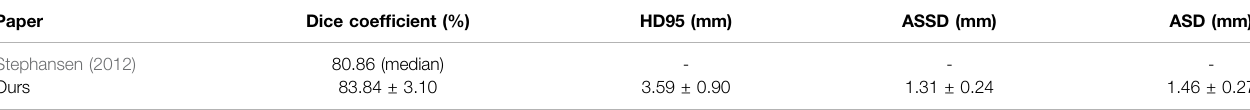
TABLE 3 | Spine segmentation results reported for Database 3.